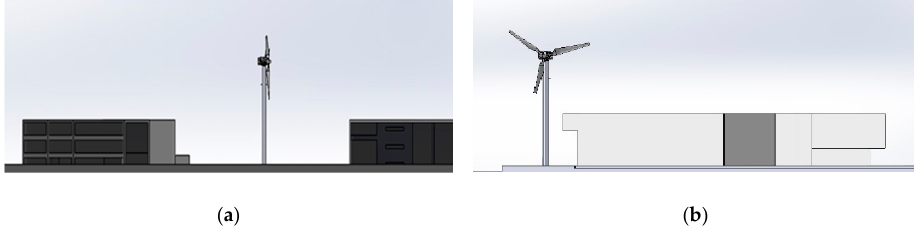
Figure 9. Scale perspective of the wind turbine and nearby buildings. ( a ) Side view, ( b ) front view.